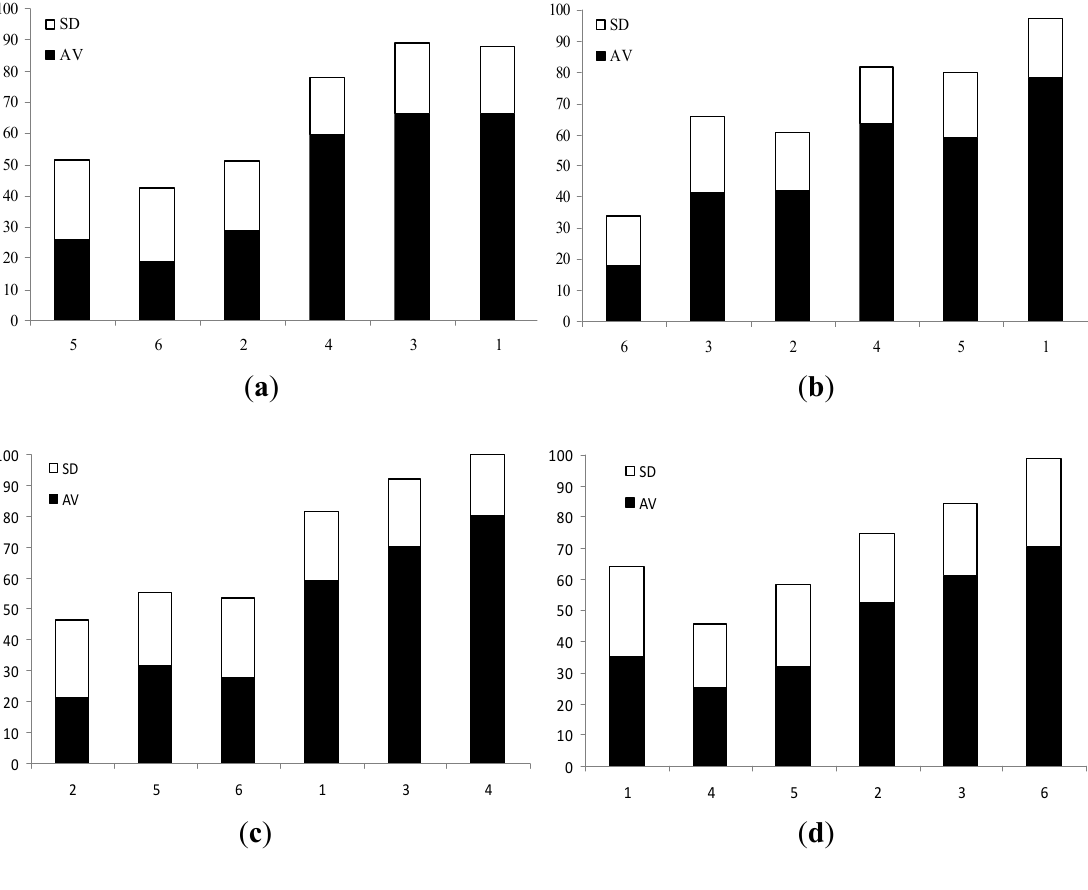
Figure 3. Stage 3 estimations (%) by social science students for the variables ( a ) aesthetics ; ( b ) land cost ; ( c ) habitat for species ; and ( d ) safety . based on different pictures represented by numbers on the x-axis. SD, standard deviation; AV,